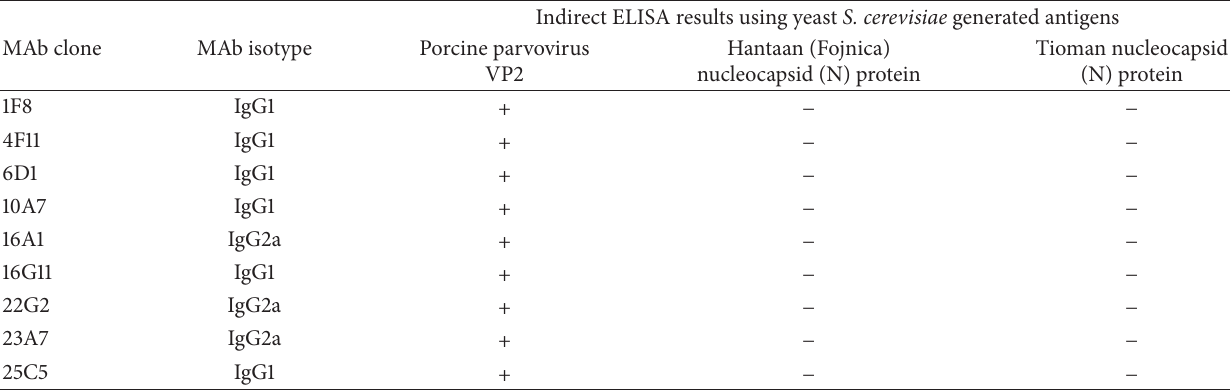
Table 2: MAb isotypes and